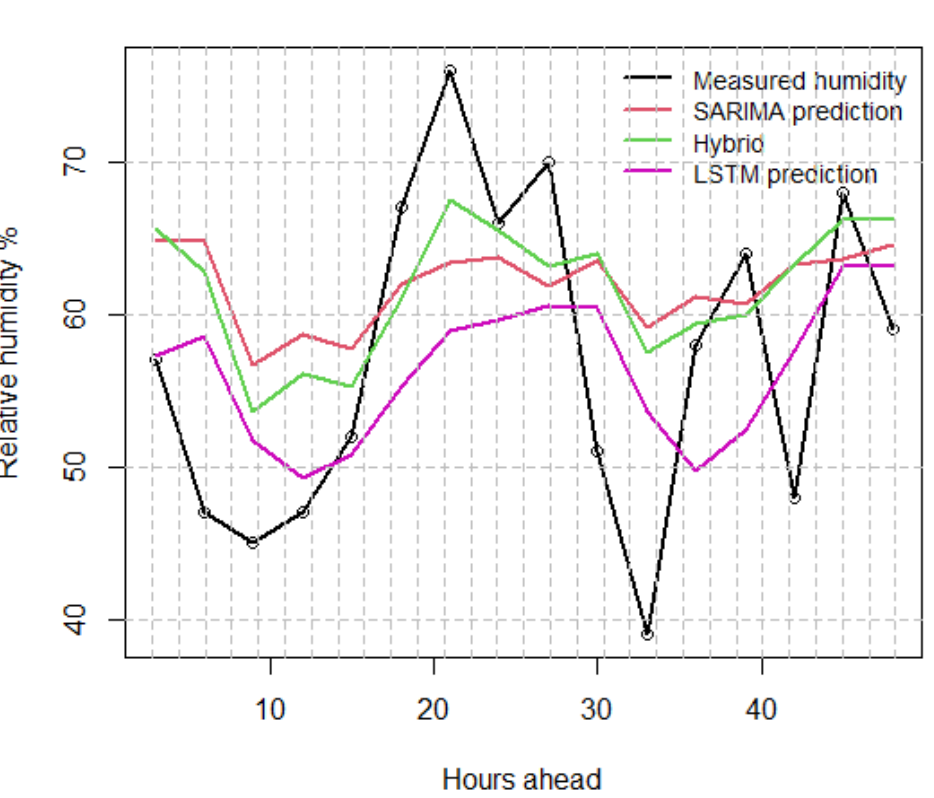
Figure 10. Comparison of SARIMA, LSTM and hybrid with real data on humidity example for 2-day prediction horizon in June; example with very big MAE.